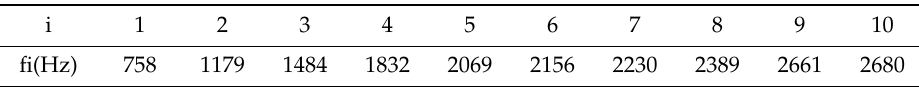
Table 2. Experimental frequencies.